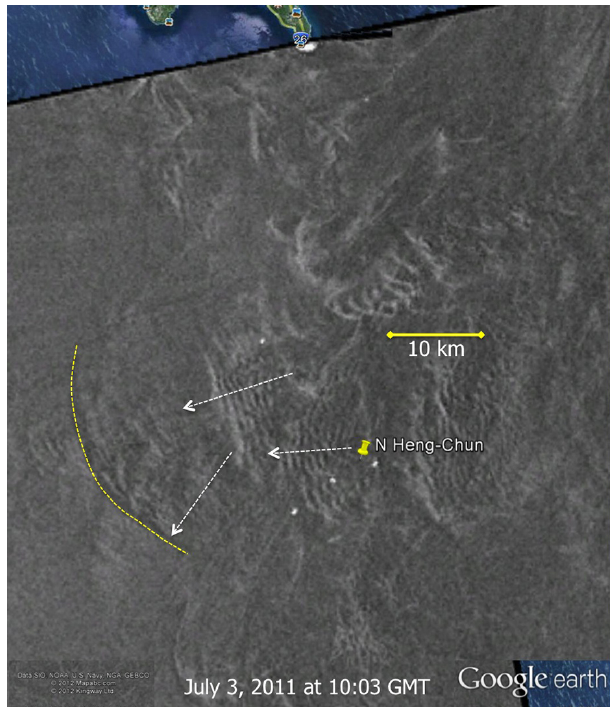
Figure 8. Satellite synthetic aperture radar (SAR) image from 3 July 2011 showing a solitary wave leading two packets, similar to the situation observed in situ on 15 August. The image was obtained during a similar phase of the tide: 3 days after new moon for 3 July and 3 days past full moon on 15 August. The push-pin indicates the mooring